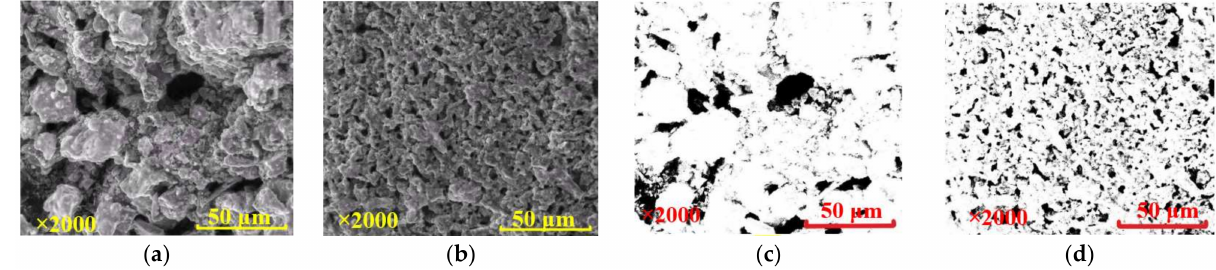
Figure 15. SEM images at 2000 magnification and binary pictures: ( a ) SEM without pumping agent; ( b ) SEM with pumping agent; ( c ) binary picture without pumping agent; ( d ) binary picture with pumping agent.